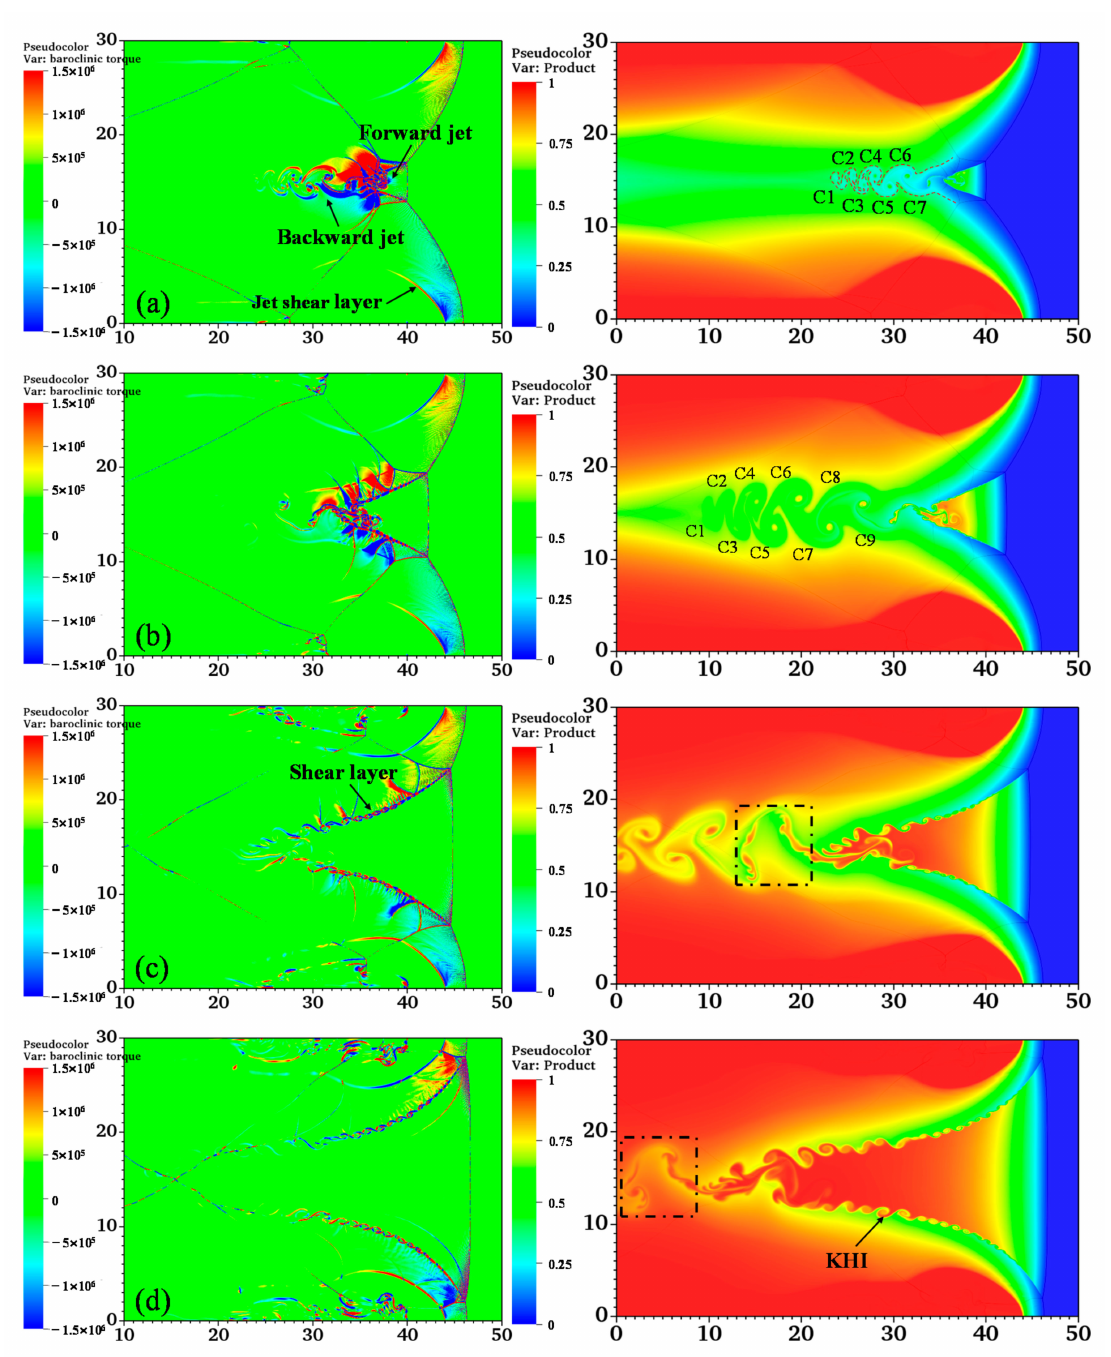
Figure 8. Large − scale RMI vortices in detonation structure after local detonation generation: ( a ) t = 155 µ s; ( b ) t = 165 µ s; ( c ) t = 177.5 µ s; ( d ) t = 187.5 µ s. Left column shows contour of baroclinic torque, ∇ ρ ×∇ p. Right column shows contour of corresponding reaction progress